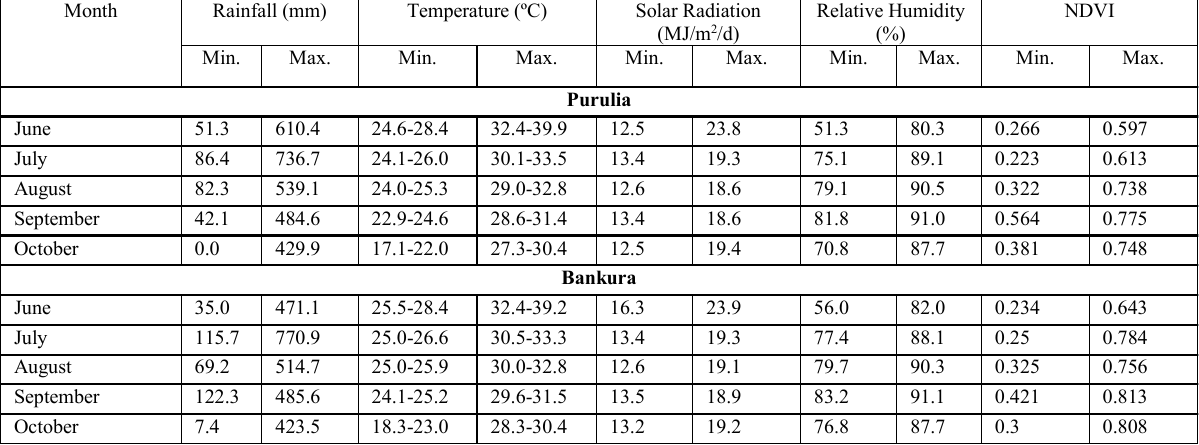
Table 1. Block level variations in monthly weather and NDVI in Purulia and Bankura districts, West Bengal during 2006-2014 (source: IMD, NASA Power & MNCFC). Purulia district – blocks yield range (kg/ha) 2006-15